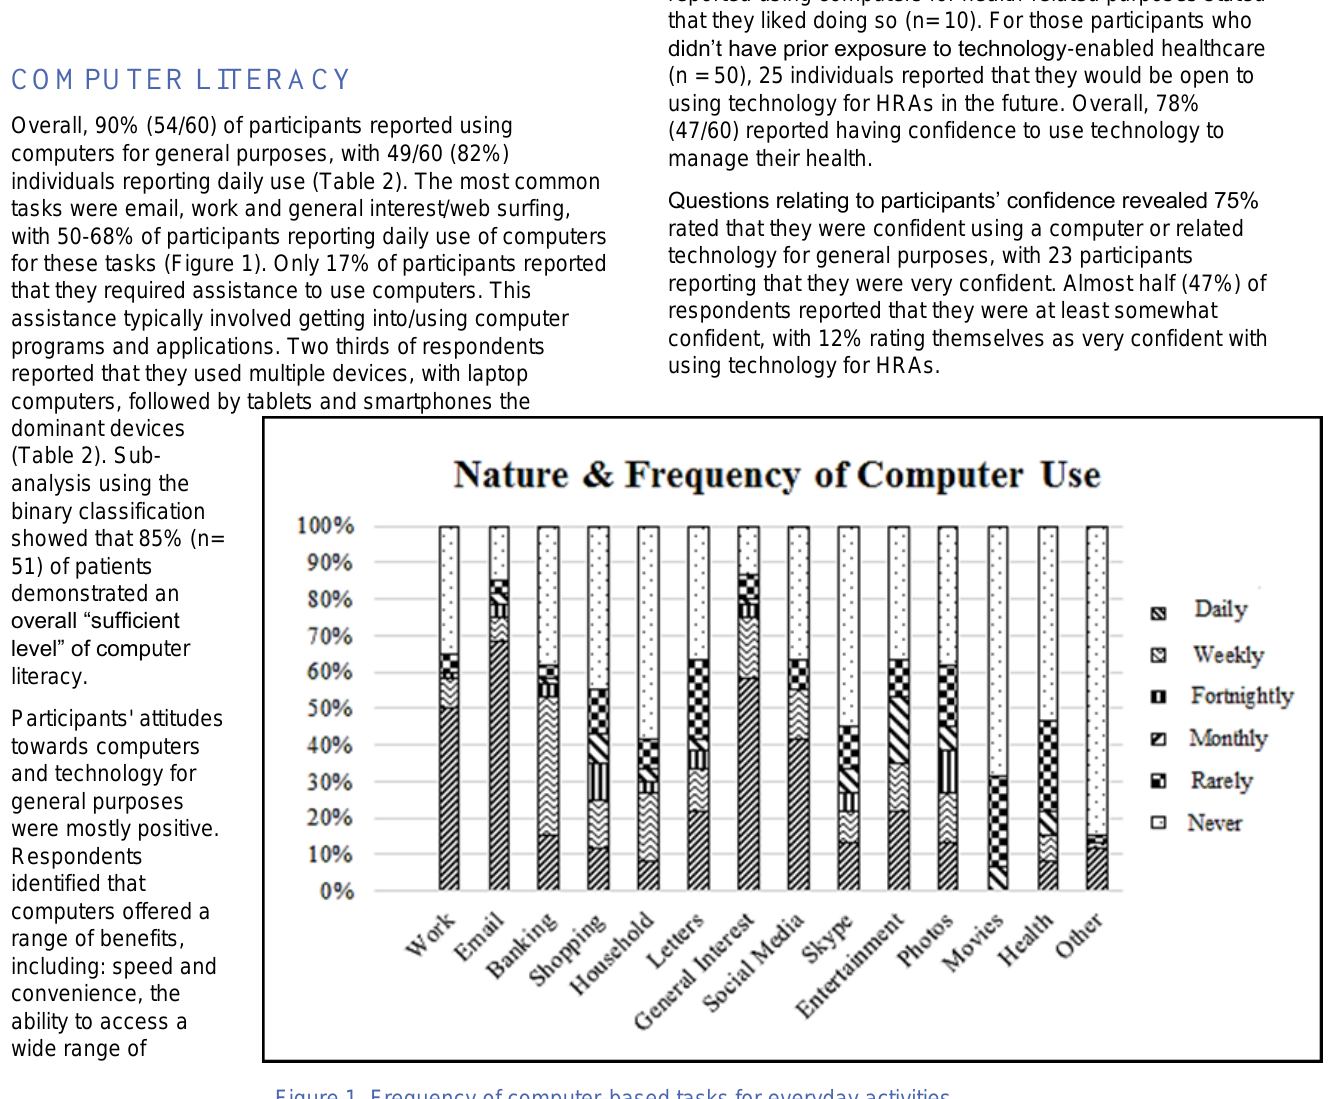
Figure 1. Frequency of computer-based tasks for everyday